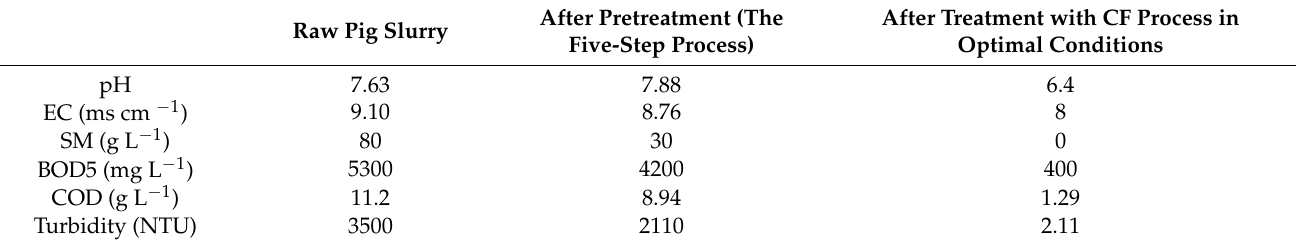
Table 1. Characterization of raw and treated pig slurry.